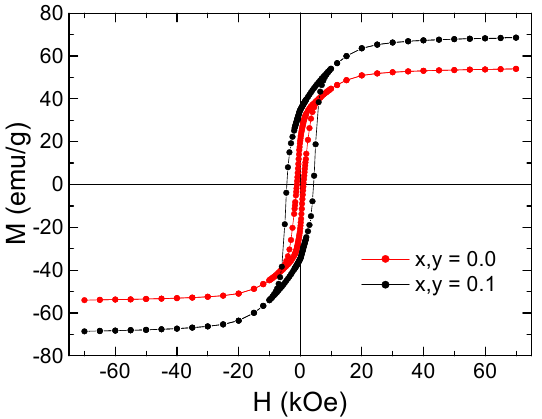
Figure 9. M–H curves of synthesized Sr 1 − x Mn x Fe 12 − y Y y O 19 (x = y = 0.0 and 0.1) nanohexaferrites performed at room temperature.